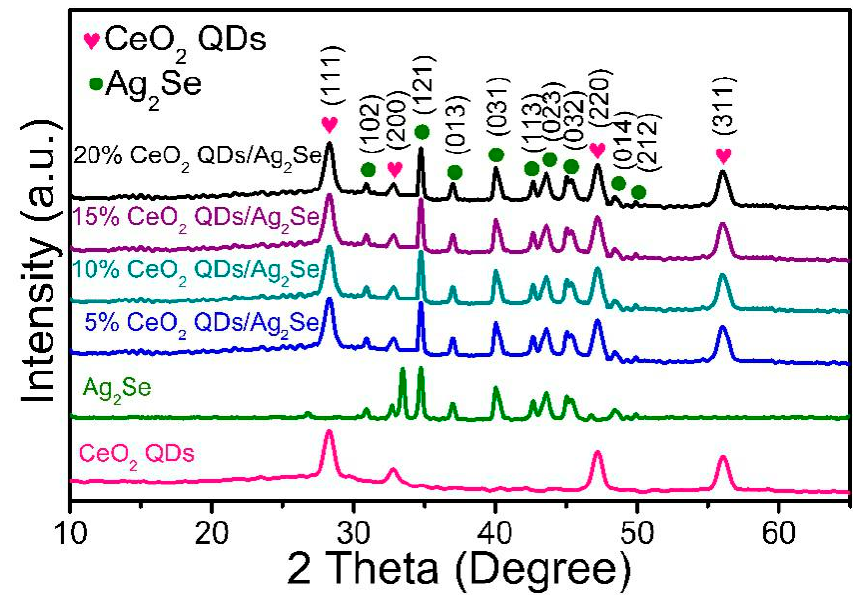
Figure 1. XRD analysis of CeO 2 QDs, Ag 2 Se, and CeO 2 QDs/Ag 2 Se with different concentrations of CeO 2 QDs.